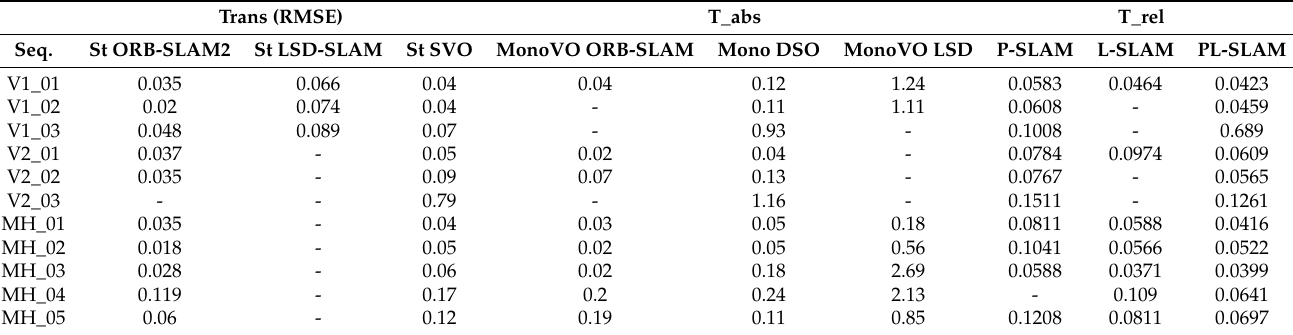
Table 2. Translational error (RMSE) on the European Robotics Challenge (EuRoC) Micro-Aerial Vehicle (MAV) Dataset for state-of-the-art VSLAM